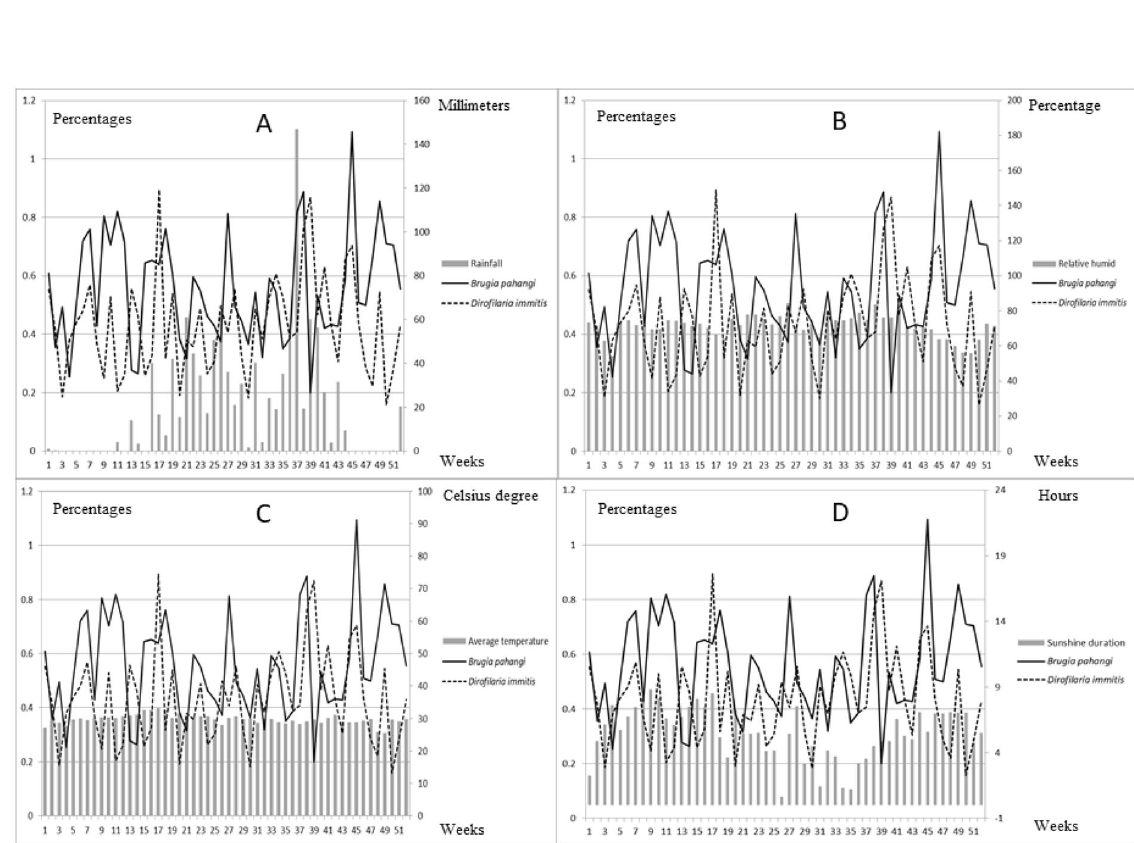
Figure 2. Line chart ( B. pahangi and D. immitis ) revealed positive of each filarial by week and bar chart demonstrate parameters including rainfall ( A ), relative humidity ( B ), average temperature ( C ) and sunshine duration ( D